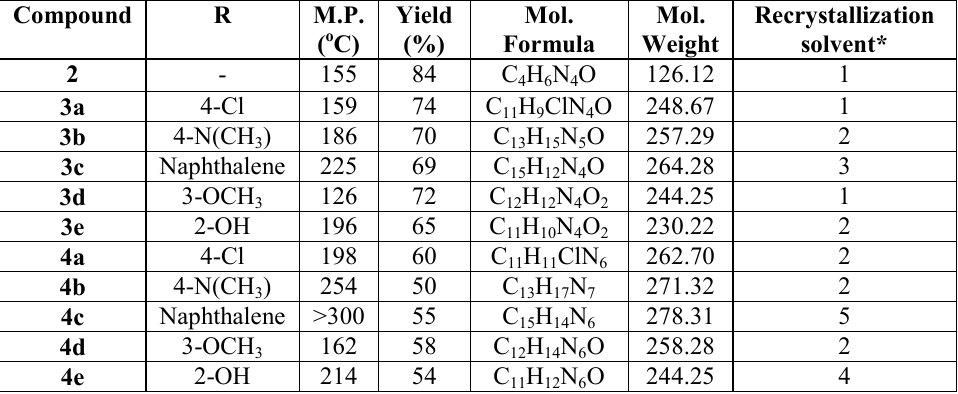
Table 1 - Physical data of synthesized compounds 2, 3a-e and